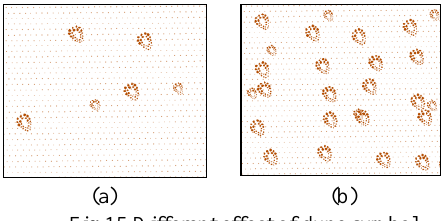
Fig.15 Different effect of dune symbol